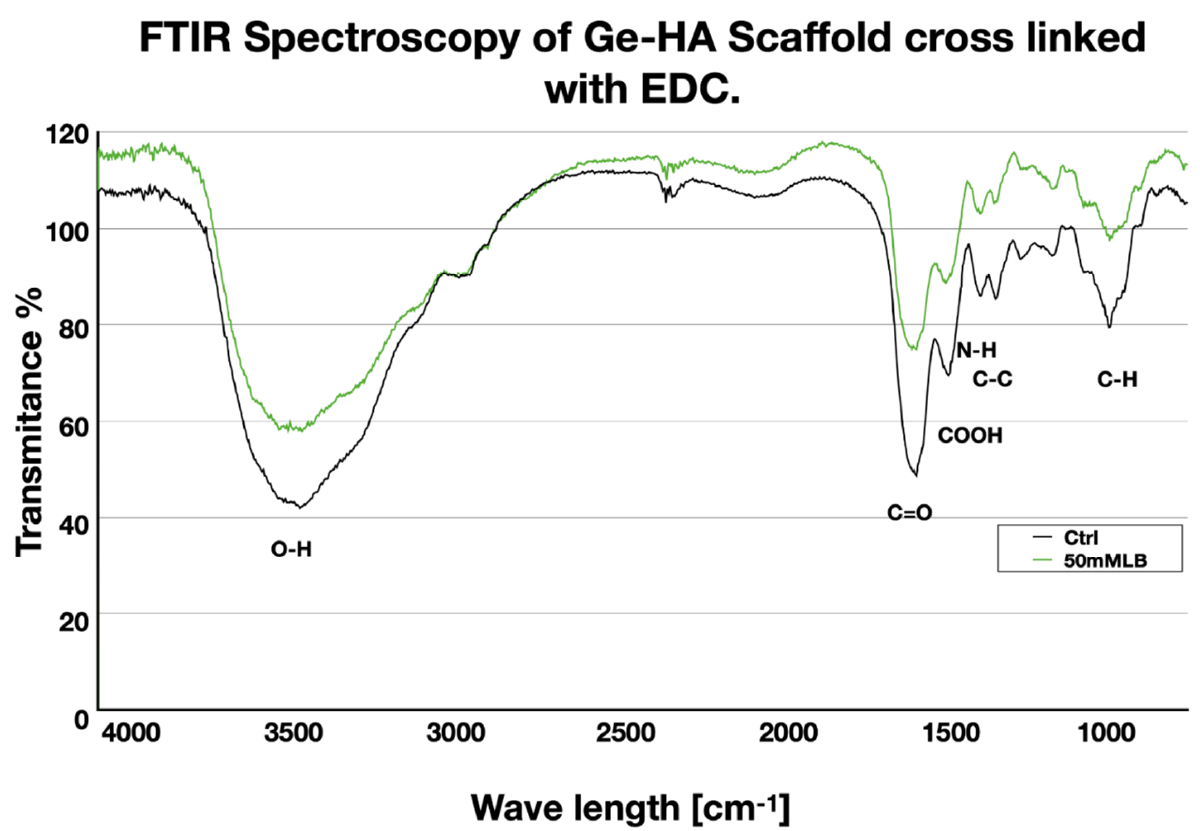
Figure 1. FT-IR spectra of Ge/HA with EDC and Ge/HA without EDC. It can be seen that both scaffolds have a similar molecular composition3.2. Surface Morphology of Ge/HA